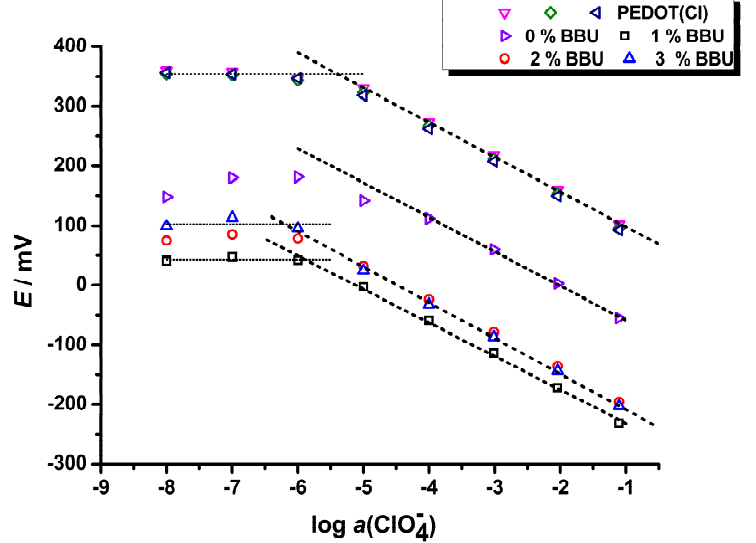
Figure 3. Calibration plots of GC/PEDOT(Cl) electrodes without ISM and with ISM containing TDMACl only and ISMs containing 1–3% BBU at a constant TDMACl/BBU ratio (Table 1). The potential of ISE with ISM containing TDMACl (0% BBU, violet triangles) were shifted with a constant value (+100 mV) for the sake of clarity.